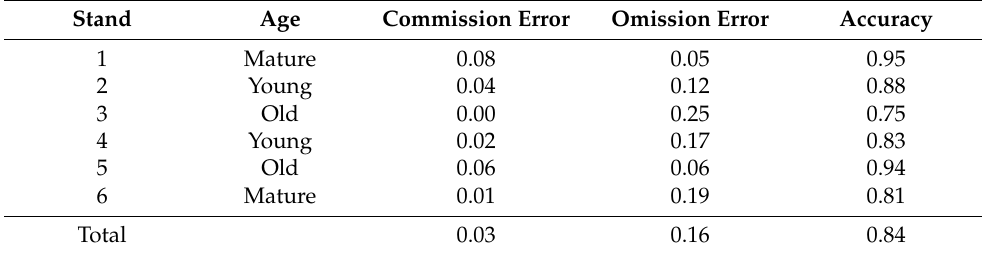
Table 3. Accuracy of the individual crown segmentation using TrEx.